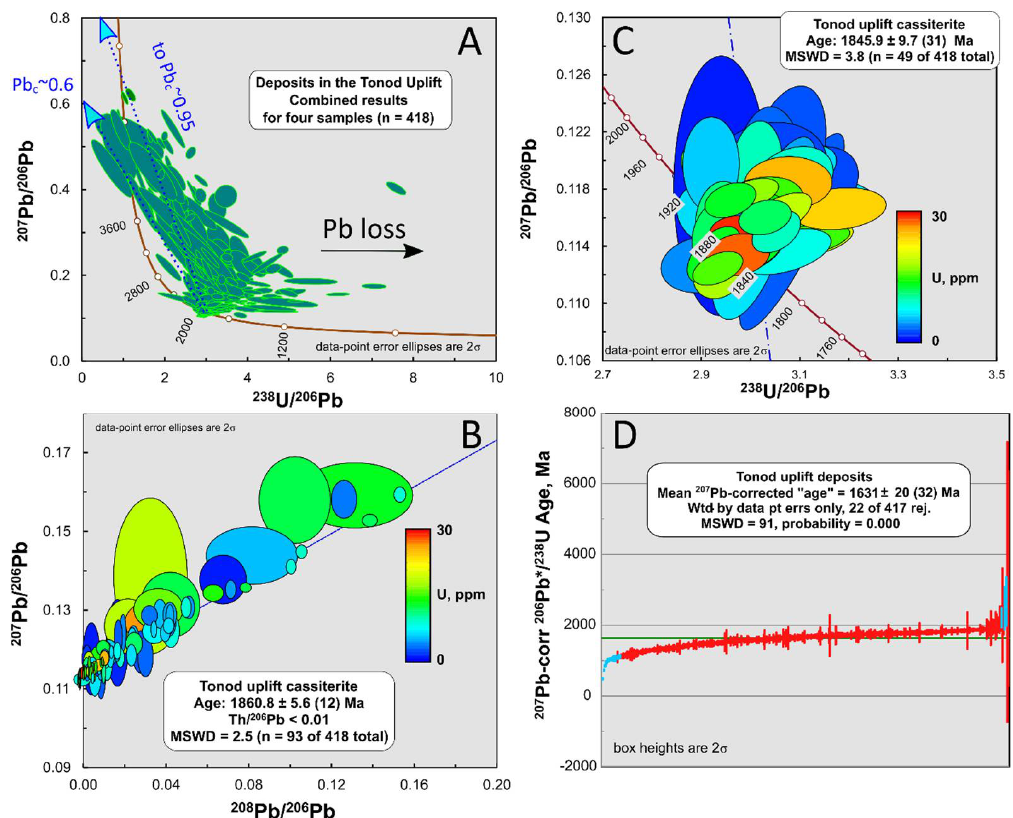
Figure 11. The U-Pb isotope data for cassiterite samples from the Tonod uplift (Tuyukan ore region), Baikal folded region. Tera-Wasserburg isochron diagrams for all spot analyses ( A ) and analyses showing the most radiogenic Pb-isotope compositions ( C ). An inverse Pb-Pb isochron ( B ) and a weighted average of the 207 Pb-corrected 206 Pb*/ 238 U ages ( D ) are also shown. The vertical lines in ( D ) represent age values with 2 standard error (2 SE) bars. The blue lines are outliers not included in the weighted average calculation.